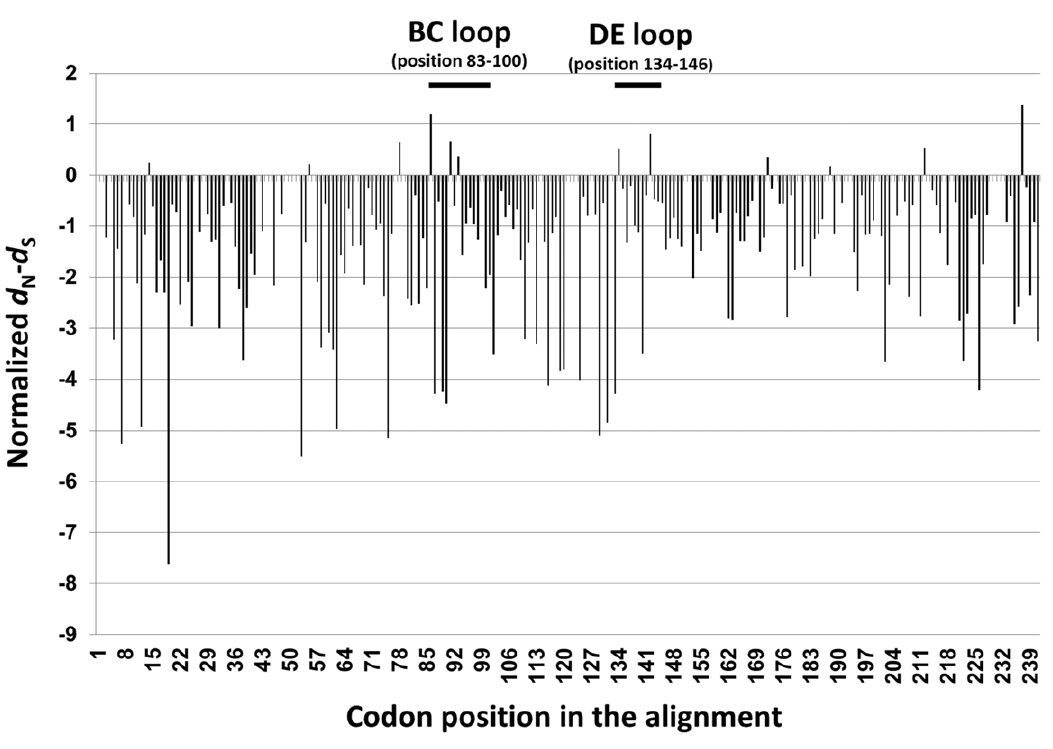
Figure 5. The ratio of nonsynonymous to synonymous substitutions ( v =d N / d S ) per codon site across the VP1 region of EV68. The residue likely to have evolved under positive selection was recognized when the v value . 1.0. Codon position assigned to this plot was based on the